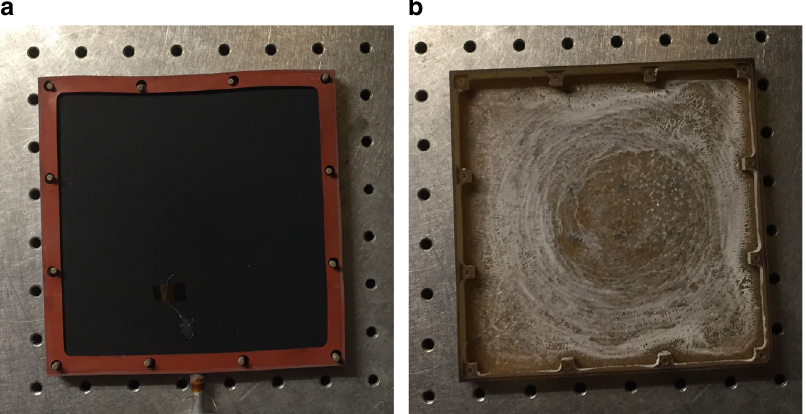
Fig. 5 Operation with sea water. a Photograph of emitter after evaporation experiment with synthetic sea water (3.5 wt% NaCl dissolved in water) showing no evidence of fouling. b Photograph of the basin after evaporation experiment with synthetic sea water showing complete evaporation and containment of salt crystals to the basin